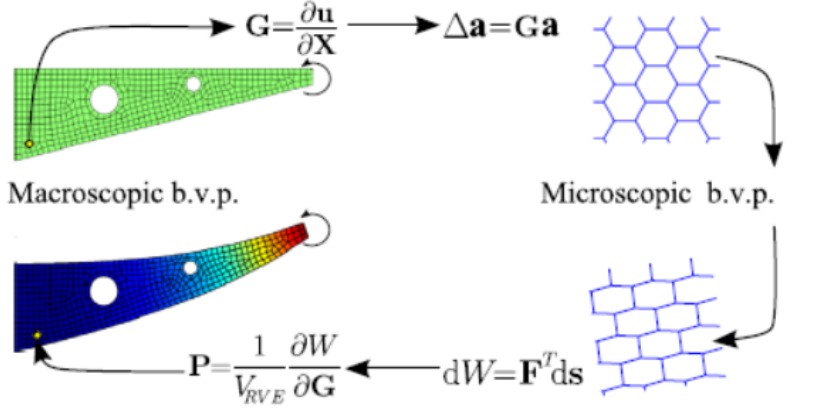
Figure 4 . Multi-scale scheme [30] . Figure 4. Multi-scale scheme